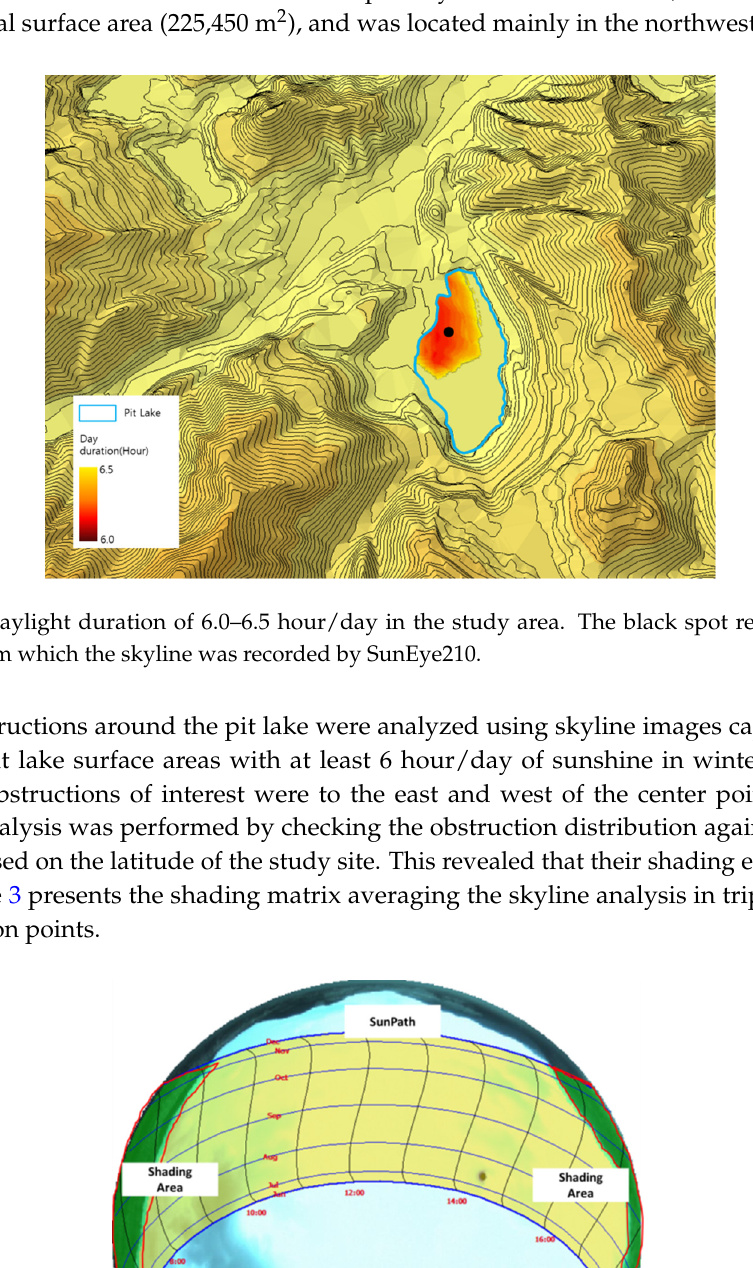
Figure 4. Result of shading analysis using SunEye210.